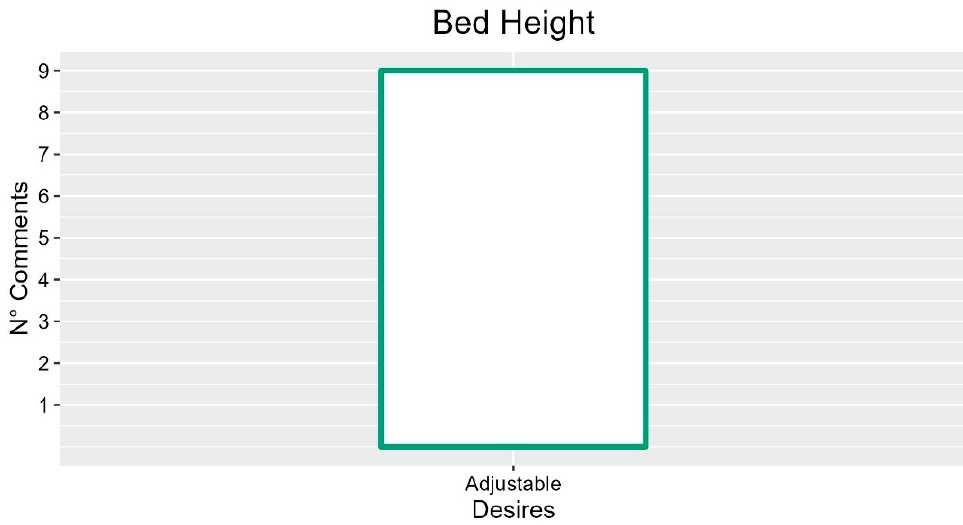
Figure 7. Graphical representation of desires with more occurrences for the Bed Height